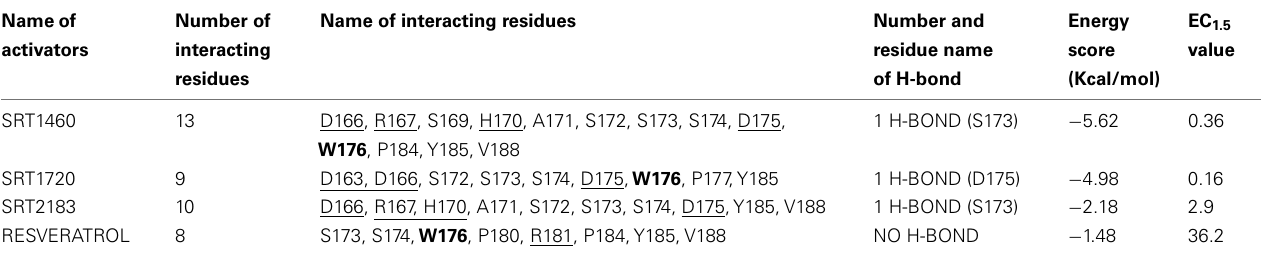
Table 4 | Interaction details of four complexes compared to experimental data reported in